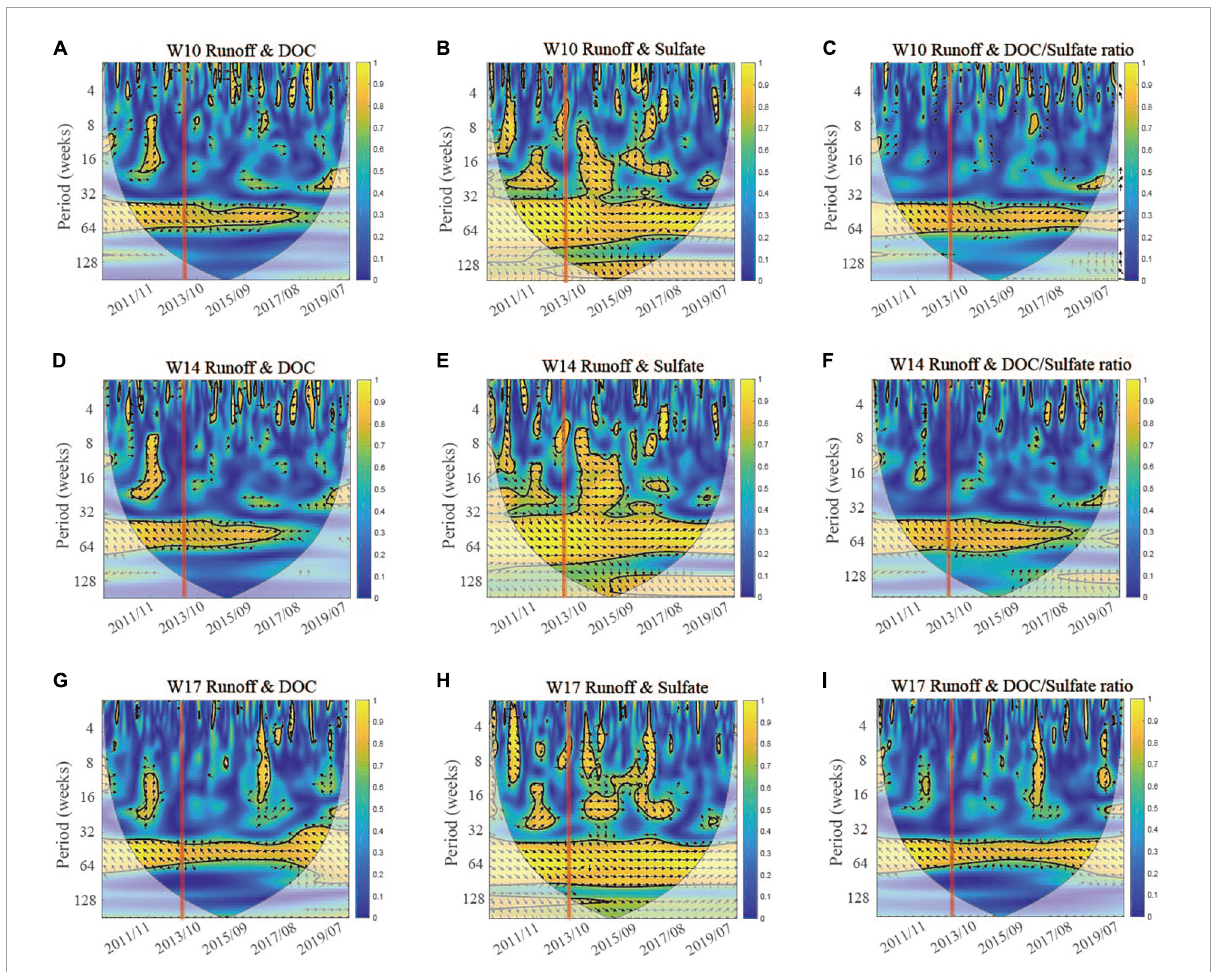
FIGURE5 The WTC analysis between runoff and dissolved organic carbon (DOC), sulfate, DOC/Sulfate ratio at 3 Wüstebach catchment stations (W10, W14, W17). The X -axis indicates the time and the y -axis displays the periods (in weeks). The cone of influence (COI) is shown as a cone-shaped area with thick black line (95% confidence level based on Monte Carlo test). The different colors indicate the strength of the correlation ( R 2 ) from 0 to 1. The black arrows indicate the orientation of the correlation with R 2 > 0.5 and the phase shifts between two variables (right directed: in-phase, positive, left directed: anti-phase, negative). The vertical red line indicates the moment deforestation occurred in late summer